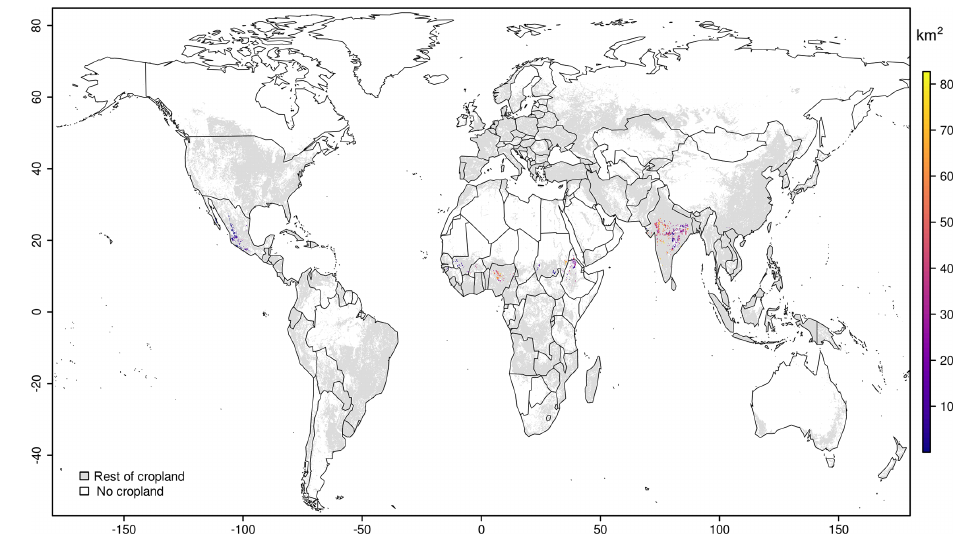
Figure 6. Reduced tillage area where soil depth to bedrock is limiting the depth of